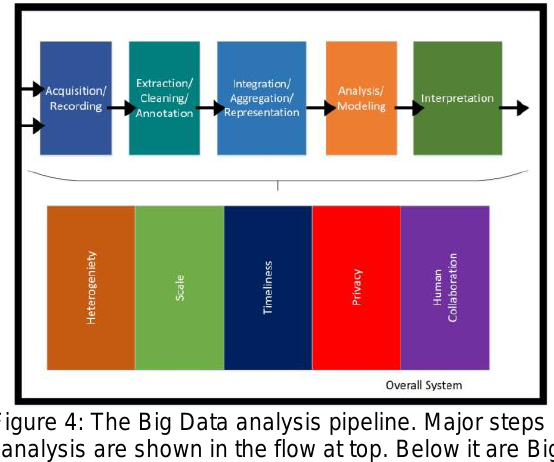
Figure 4: The Big Data analysis pipeline. Major steps in analysis are shown in the flow at top. Below it are Big Data needs that make these tasks challenging